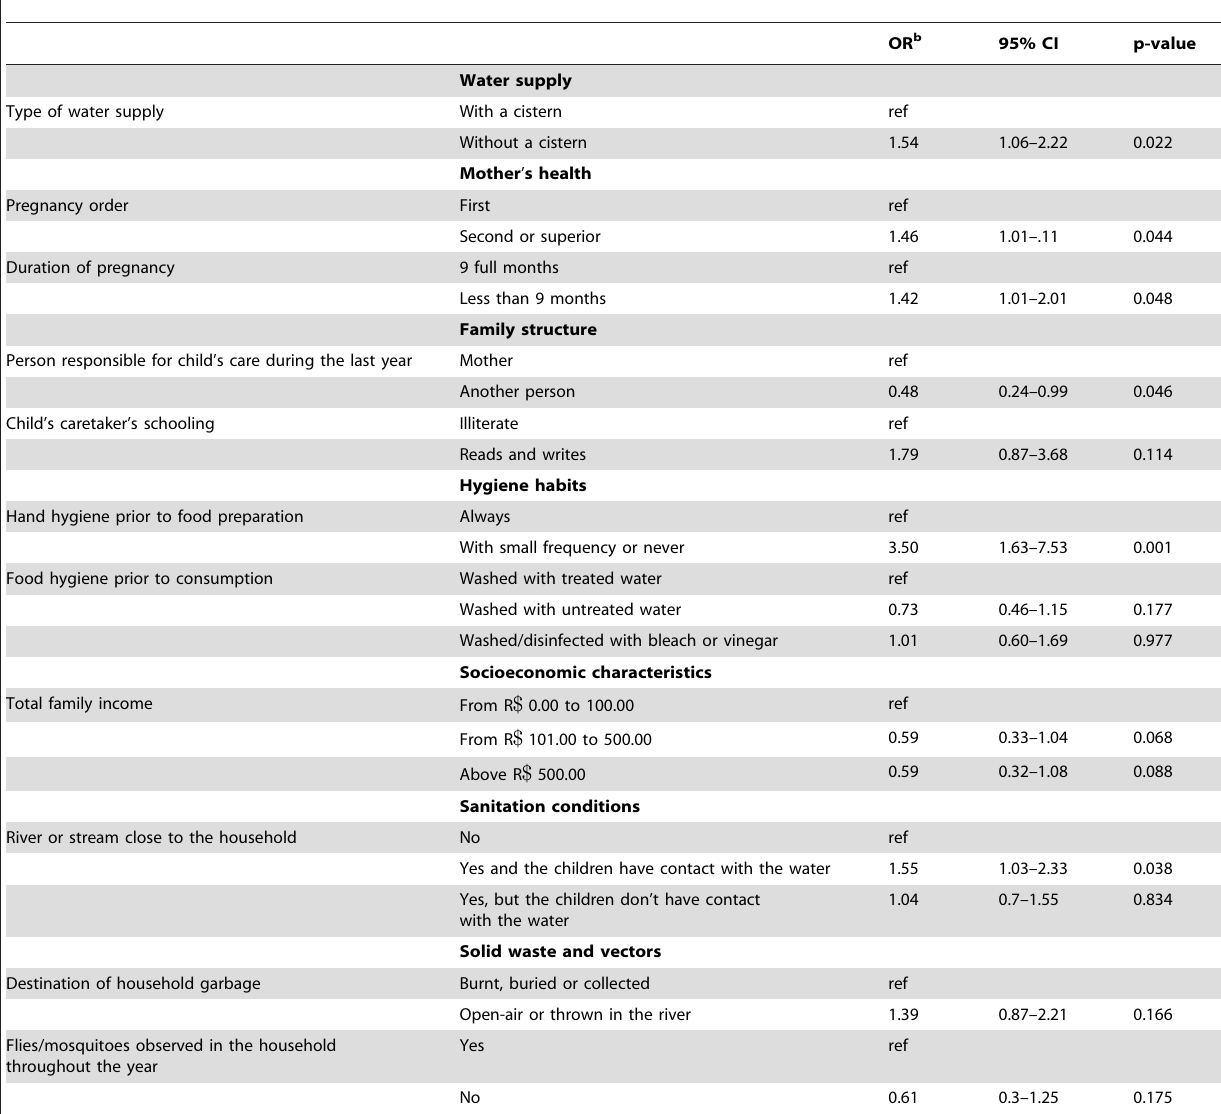
Table 4. G. duodenalis infection in children in Northeast region of Minas Gerais State, Brazil, 2009–2010; categorical variables selected in the univariate analysis a